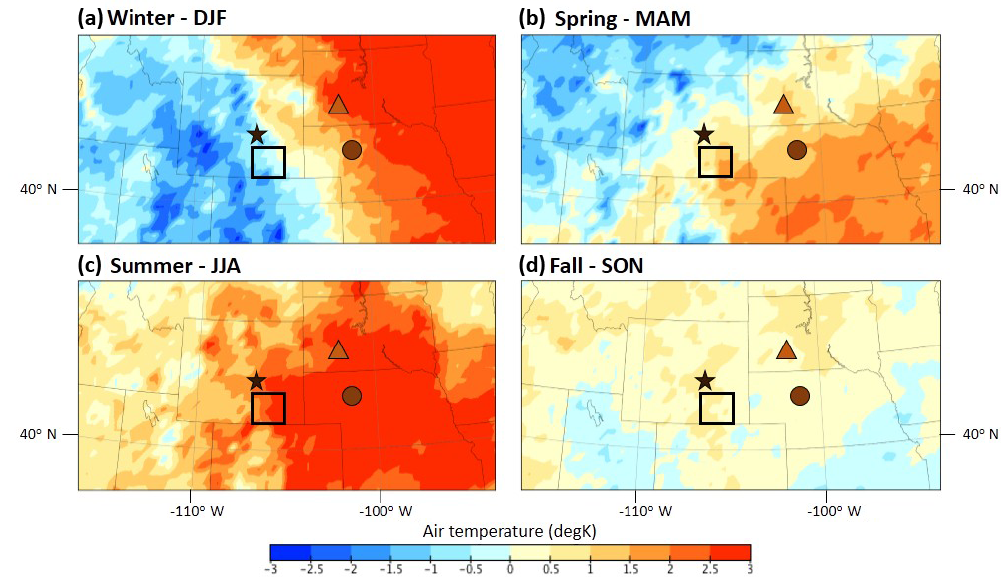
Figure 6. Composite-anomaly maps for air temperature at the surface during (a) winter(DJF); (b) spring (MAM); (c) summer (JJA); (d) and fall (SON). Positive values (warm colours) for air temperature indicate warmer-than-normal conditions. Negative values (cool colours) indicate cooler-than-normal conditions. The black box denotes the study site, Long Lake in the Medicine Bow Mountains of southeastern Wyoming. The black star denotes the Ferris and Casper dune fields; the orange triangle denotes the White River Badlands dunes; and the brown circle denotes the Nebraska Hills sand dunes. Light grey lines depict lines of latitude and